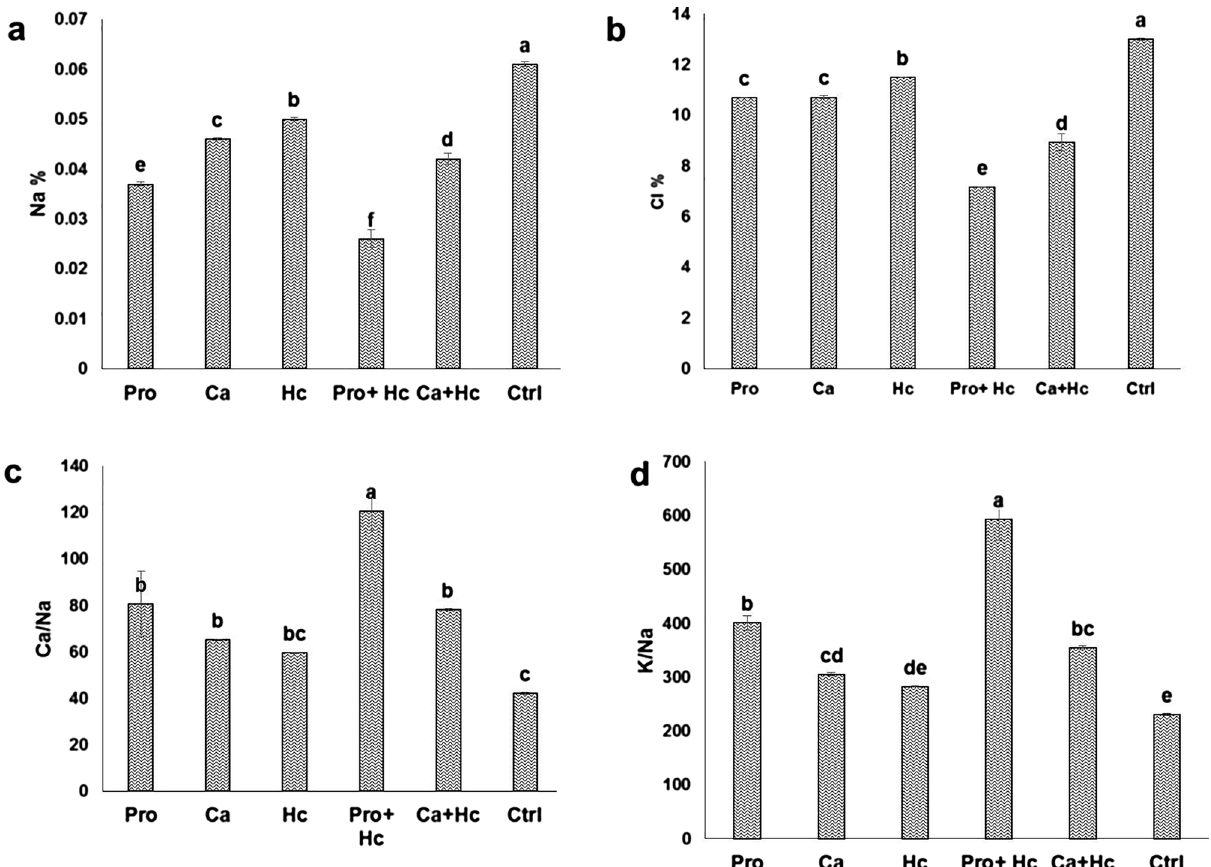
Figure 3. Effect of Proline (Pro) and Calcium (Ca) as foliar application alone or incombination with humic acid (Hc) as soil application on ( a ) leaves sodium (Na), ( b ) chloride (Cl), ( c ) calcium/sodium ratio (Ca/Na), ( d ) potassium/sodium ratio (K/Na) based on leaves dry weight of ‘Wonderful’ pomegranate trees grown under salt stress conditions. The different letters on the bars in each column represent significant difference at p ≤ 0.05; errors bars are standerd error of three replicates. Pro: 5 mM proline alone as foliar application; Ca: 1.5% calcium as foliar application alone; Hc: 15 g humic acid as soil application alone; Pro + Hc: 5 mM porline and 15 g humic acid; Ca + Hc: 1.5% calcium and 15 g humic; Ctrl: control (non